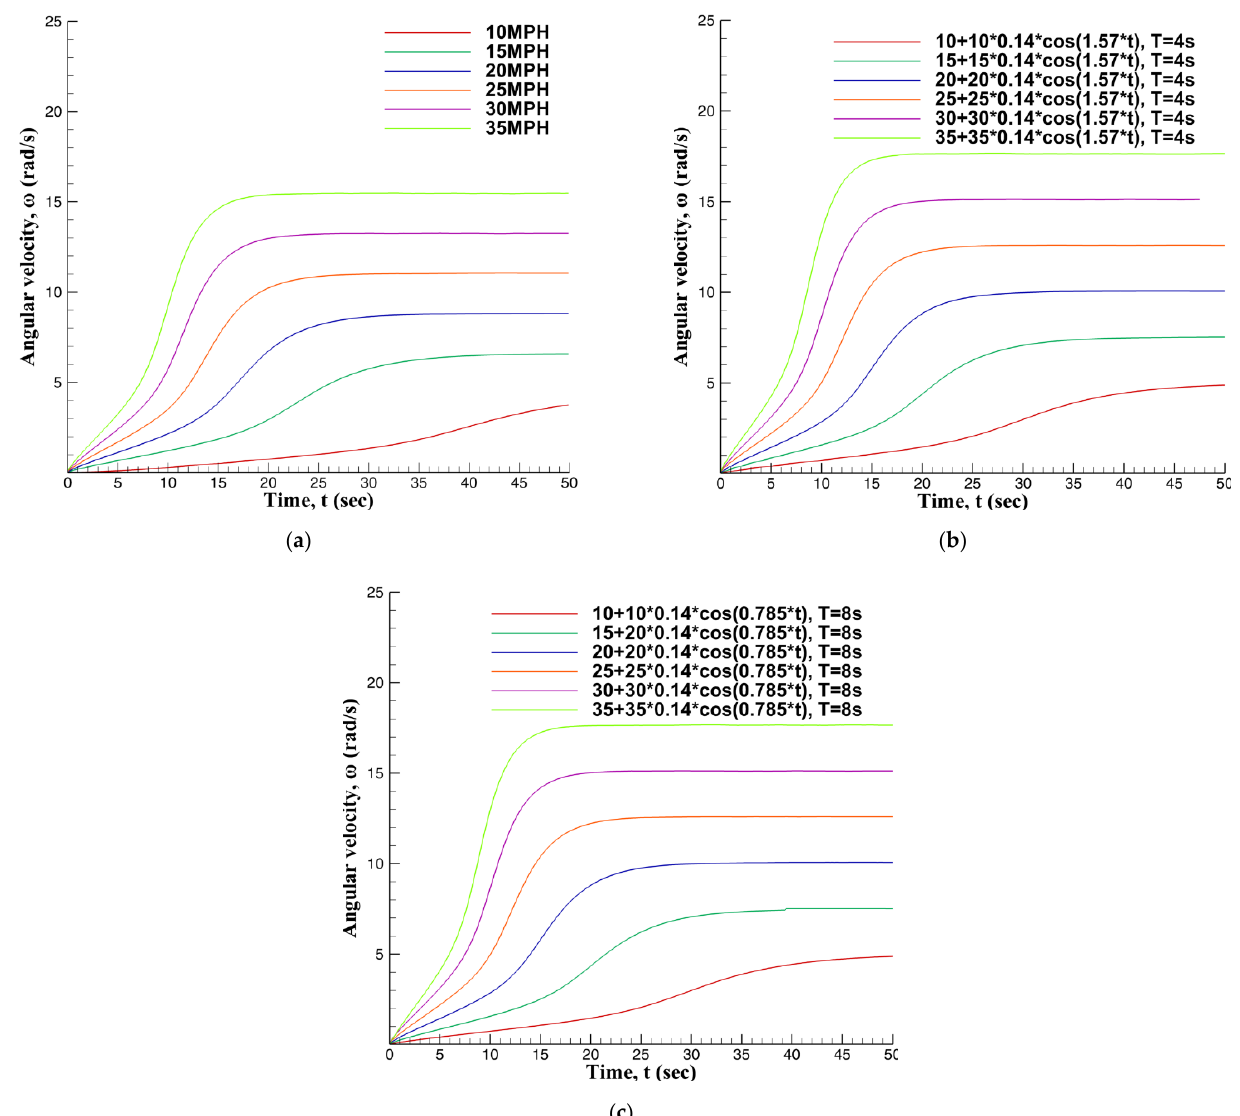
Figure 4. The evolution processes of the angular velocity of the rotor activated from stationary by the various uniform wind fields. ( a ) Steady wind field; ( b ) periodic wind field, T = 4 s; ( c ) periodic wind field, T = 8 s.